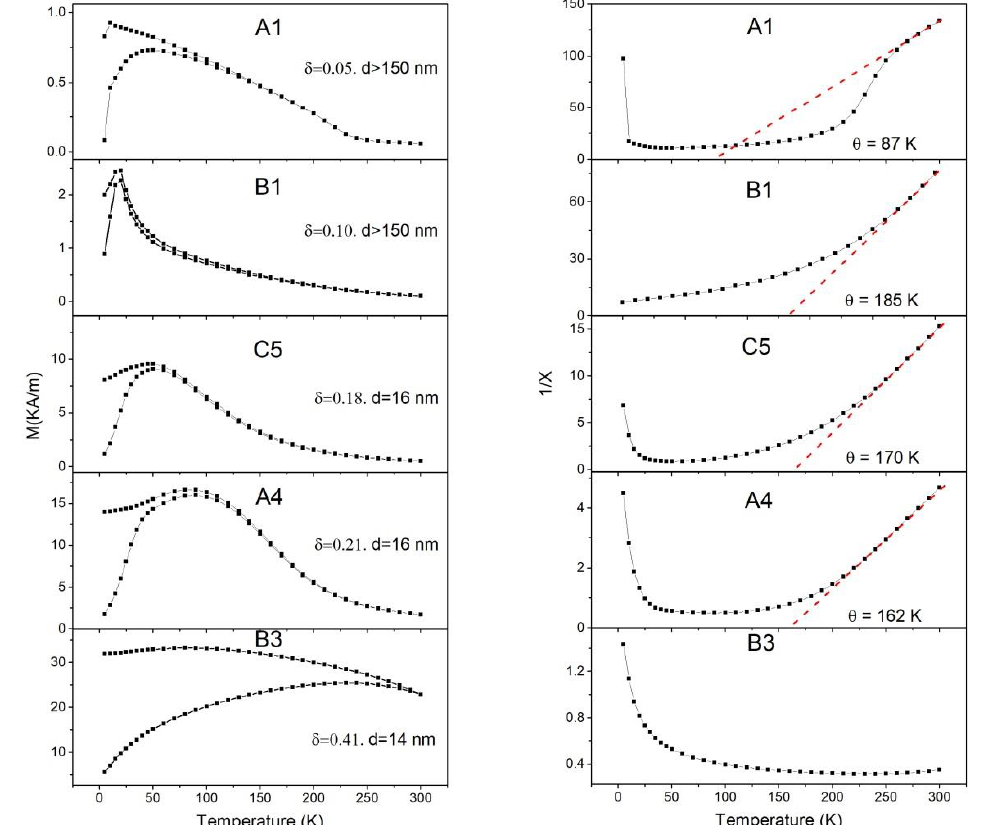
Figure 1. ( Left panel ) shows ZFC-FC curves of zinc ferrites with different inversion degree ( δ ) and crystallite size (d). The ( right panel ) shows the inverse of the dimensionless susceptibility and the corresponding linear fit with the Curie – Weiss law. The samples labels are identified in Table 2. Table 2. Inversion degree, saturation magnetization, apparent Curie–Weiss ( θ ), and average blocking temperature <T B > of the studied